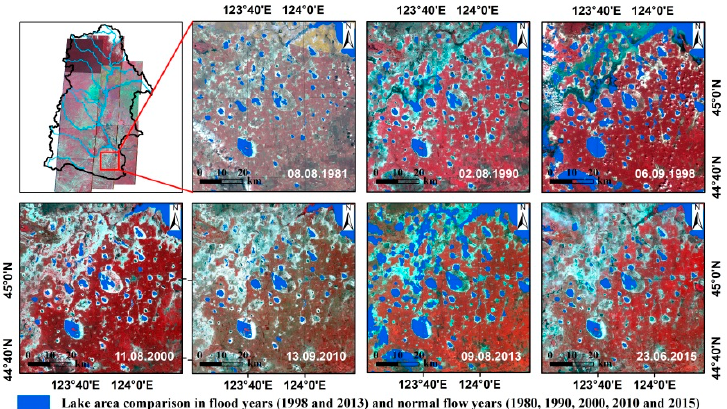
Figure 10. Increased lake area due to floods in 1998 and 2013.